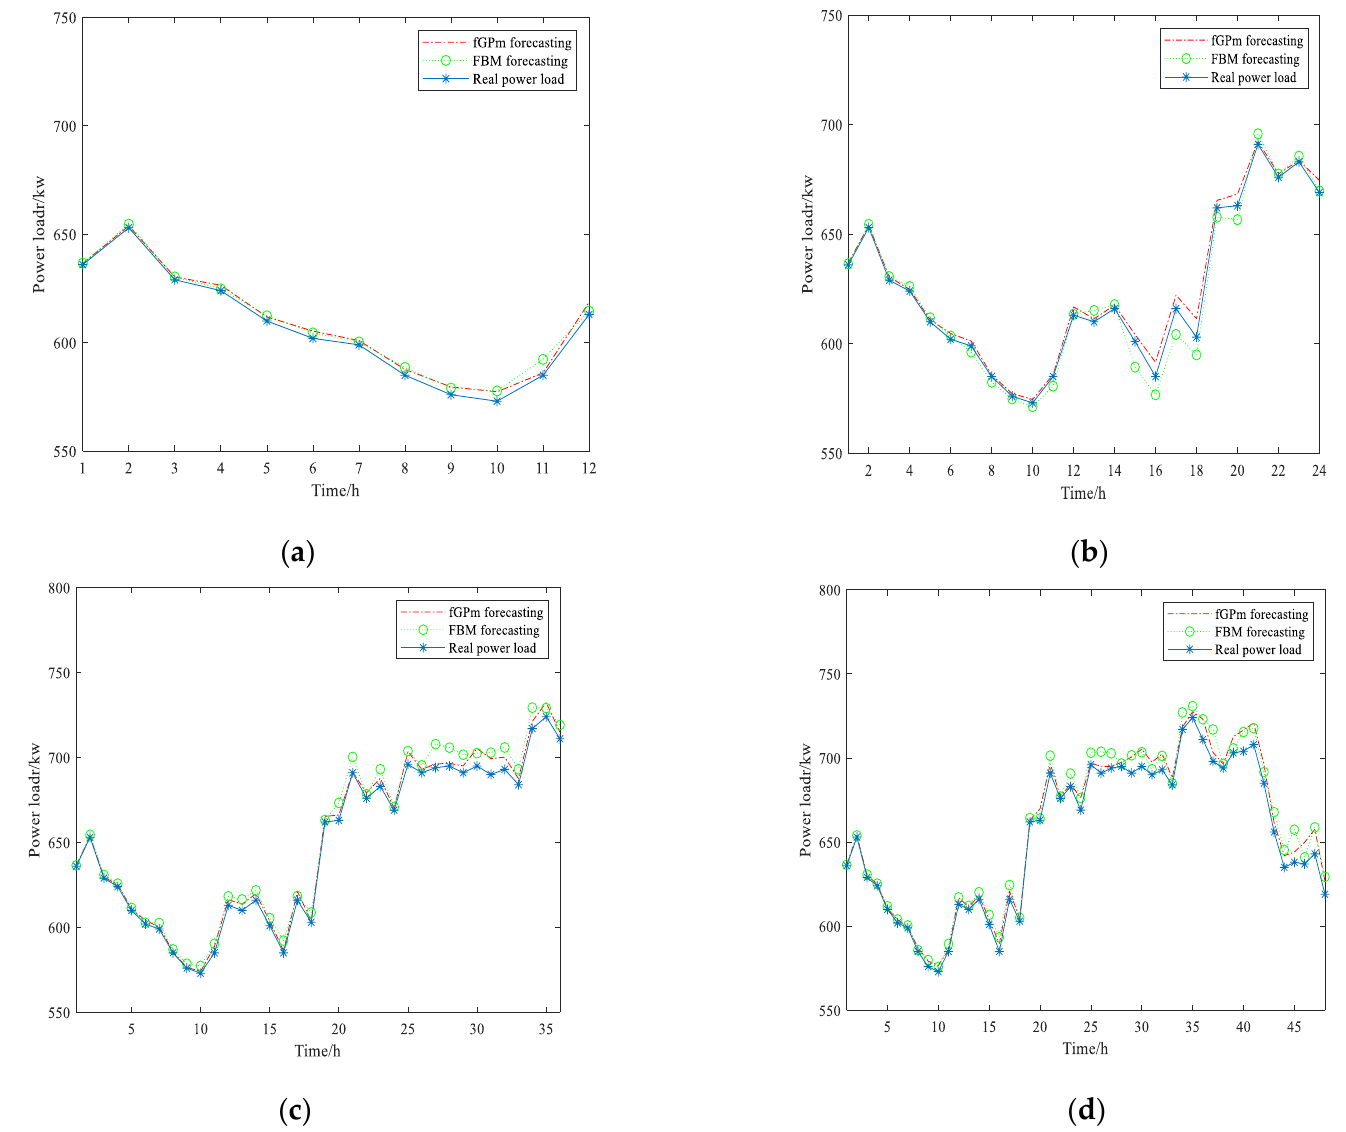
Figure 13. Comparison of two forecasting models in working days. ( a ) 6 h ( b ) 12 h ( c ) 18 h ( d ) 24 h. Table 3. The workday forecasting relative error (%) of power loads on adjacent dates. Forecast